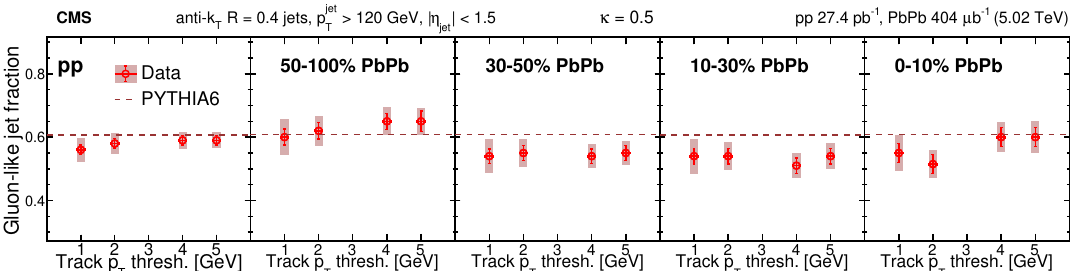
Figure 2 . The standard deviation of the jet charge distributions with di(cid:11)erent track p and (cid:20) values for pp collisions and in the various event centrality bins for PbPb collisions compared with the pythia 6 prediction. The systematic and statistical uncertainties in the standard deviation measurements are shown by the shaded regions and vertical bars, respectively.